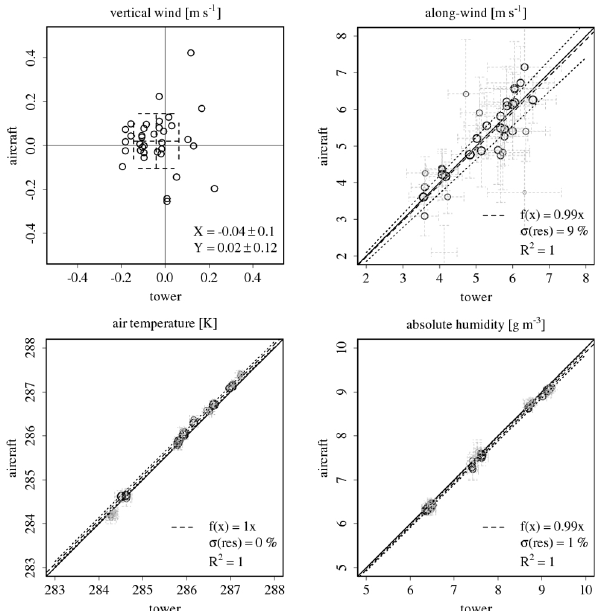
Fig. 2. Comparison between tower and WSMA averages of vertical- and along-wind components, temperature and absolute humidity. Average and standard deviation are given for the vertical wind. For along-wind, temperature and humidity, the solid, dashed and dotted lines are the 1 : 1 line, the maximum likelihood functional relation- ship, and the 99.5% confidence interval, respectively. Additional information is given in the